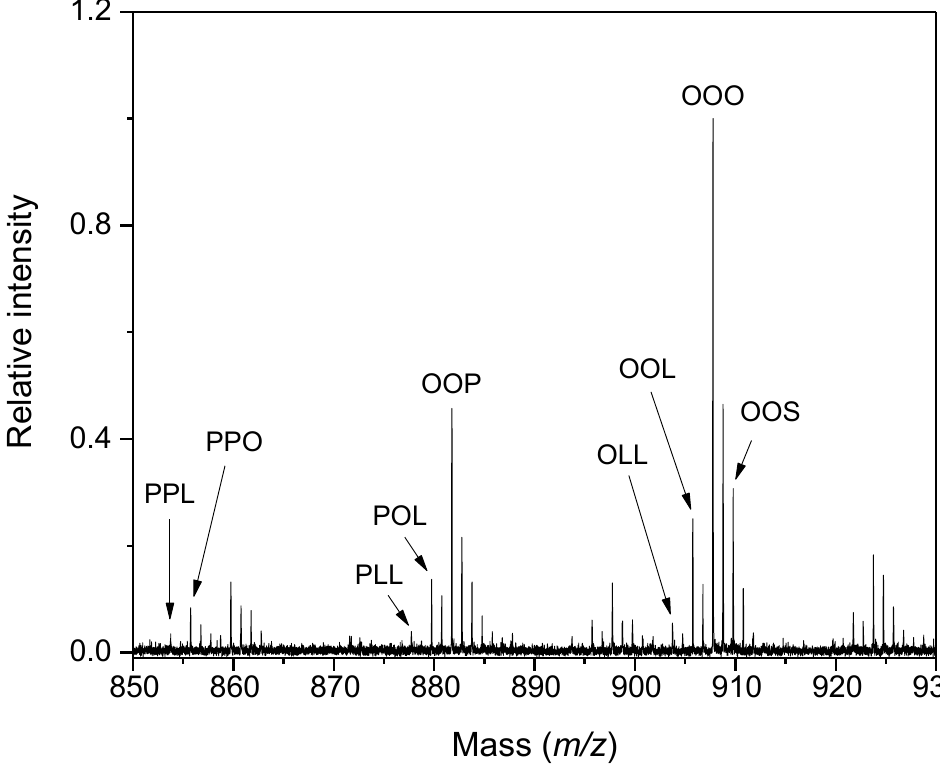
Figure 2. MALDI-TOF MS of TAGs in olive oil. This commercial virgin olive oil sample was measured using an ultrafleXtreme instrument (Bruker Daltonics). The depicted spectrum was acquired in the reflector positive ion mode with a stainless-steel target and DHB as a matrix according to De Marchi et al. [64]. Common TAGs were detected between m/z 850 and 930, mostly as sodium (but also potassium) adduct peaks. The labeling of selected sodiated ion peaks was done according to Calvano et al. [53]: L stands for linoleic acid, O for oleic acid, P for palmitic acid, and S for stearic acid. The content is author´s own work.